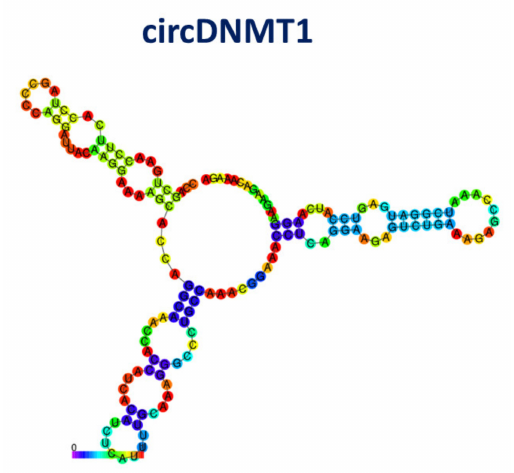
Figure 12. Drawing of the best model for the secondary structure of circDNMT1; colors of the spots indicate the corresponding pair-base probability (see the scale at the